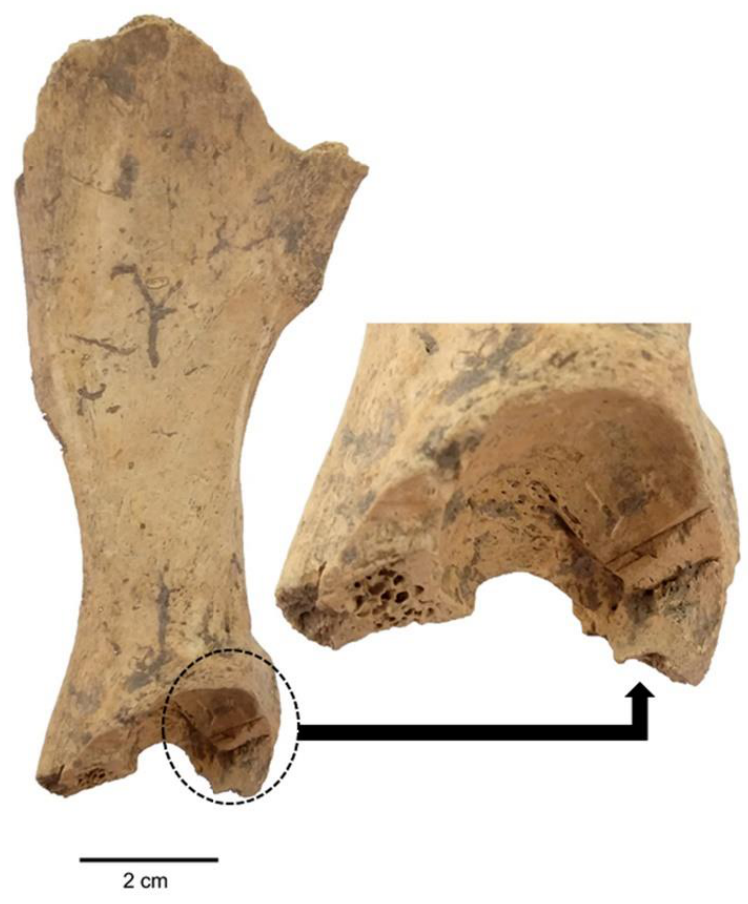
Figure 9. Cut and chop marks in the right coxal bone of an Alaybeyi dog.